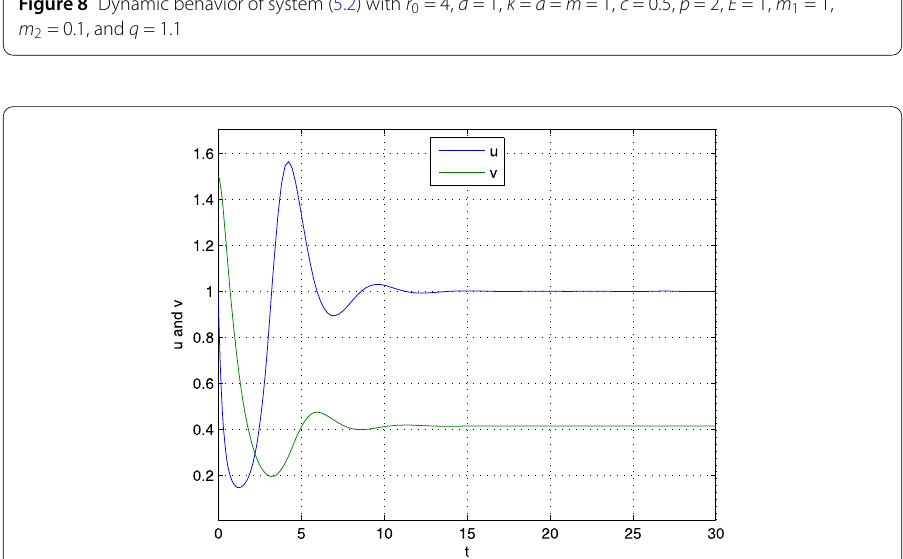
Figure 9 Dynamic behavior of system (1.1) with r 0 = 4, d = 1, a = 1, p = 2, E = 1, m 1 = 1, m 2 = 0.1, c = 0.5, k = 1, and q =